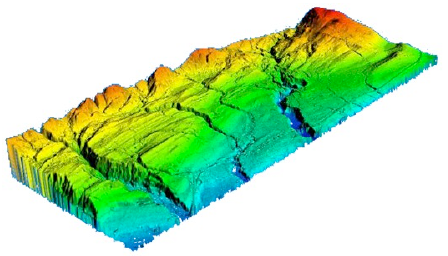
Figure 1. Terrain mapping with a